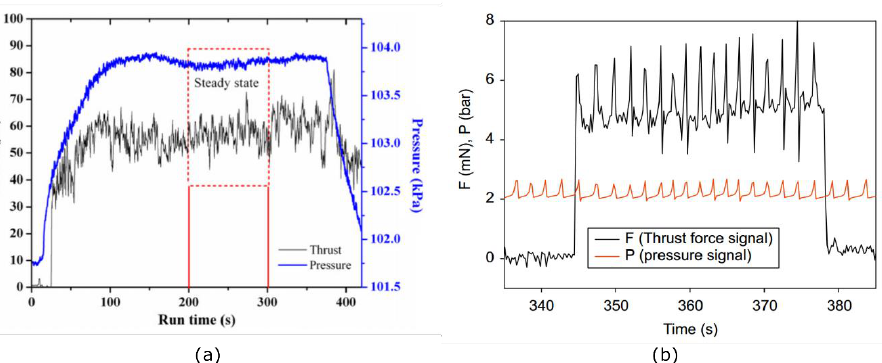
Figure 6. Experimental feeding pressure and thrust force: ( a ) single-channel VLM by Karthikeyan